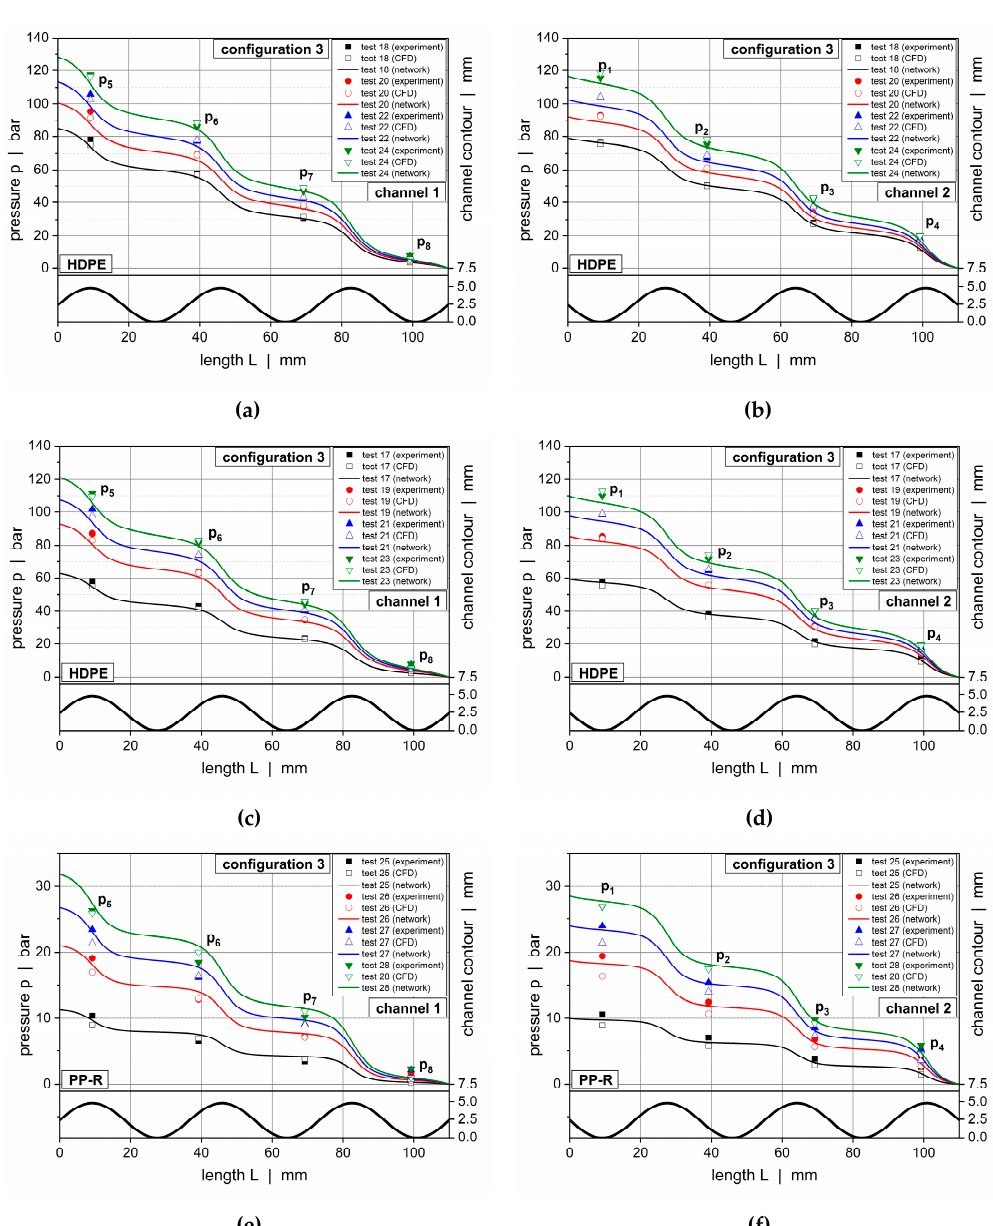
Figure 21. Comparison between experimental data and calculated solutions (seminumerical approach based on network theory vs CFD simulation). Downchannel pressure profiles for test configuration 3 and various materials: HDPE, channel 1 ( a ); HDPE, channel 2 ( b ); HDPE, channel 1 ( c ); HDPE, channel 2 ( d ); PP-R, channel 1 ( e ); and PP-R, channel 2 ( f ).